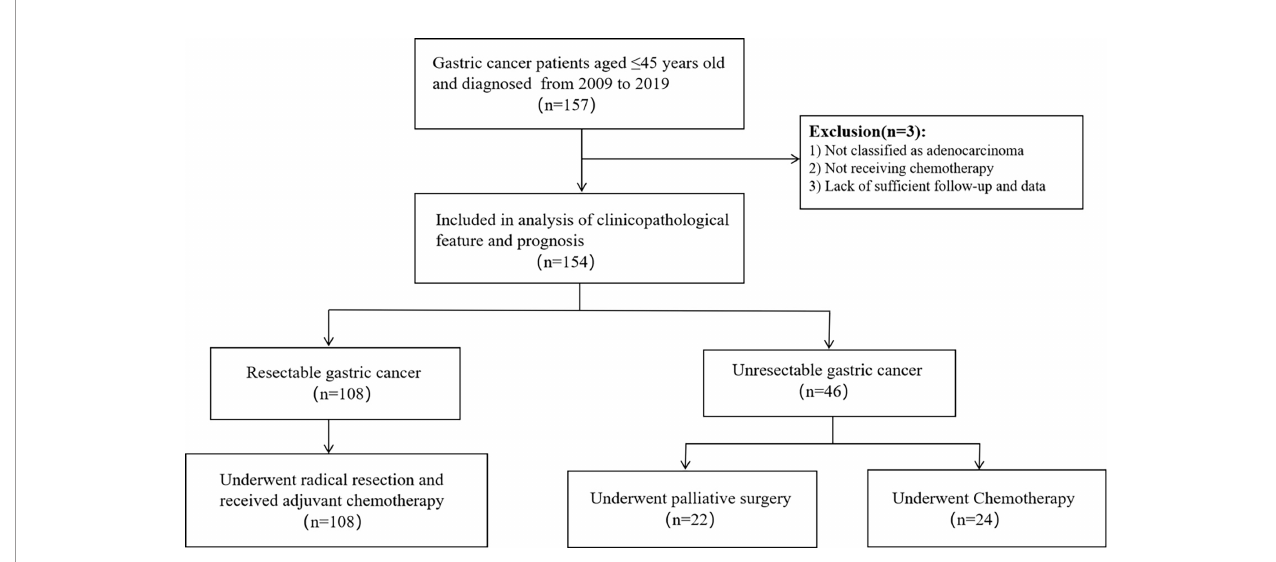
FIGURE 1 | Flowchart of the selection procedure about young gastric